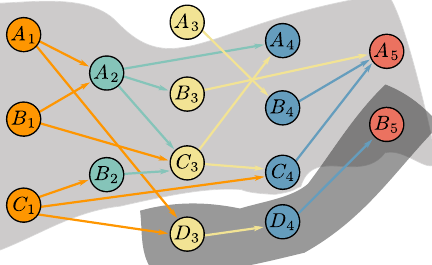
FIG. 26. (Quantum) causal network. Performing different interventions allows for the causal relations between different events (denoted by X j ) to be probed. For example, in the figure the event B 1 directly influences the events C 3 and A 2 , while A 3 influences only B 4 . As not all pertinent degrees of freedom are necessarily in the control of the experimenter, such scenarios can equivalently be understood as an open system dynamics. Any such scenario can be described by a process tensor [248], and the GET applies, even though active interventions must be performed to discern causal relations. For example, the events D 3 , D 4 , B 5 could be successive (e.g., at times t 3 , t 4 and t 5 ) spin measurements in z , x , and z direction, respectively. Summing over the results of the spin measurement in x direction at t 4 would not yield the correct probability distribution for two measure- ments in z direction at t 3 and t 5 only, but consistency still holds on the level of process tensors (see also Sec. IV D